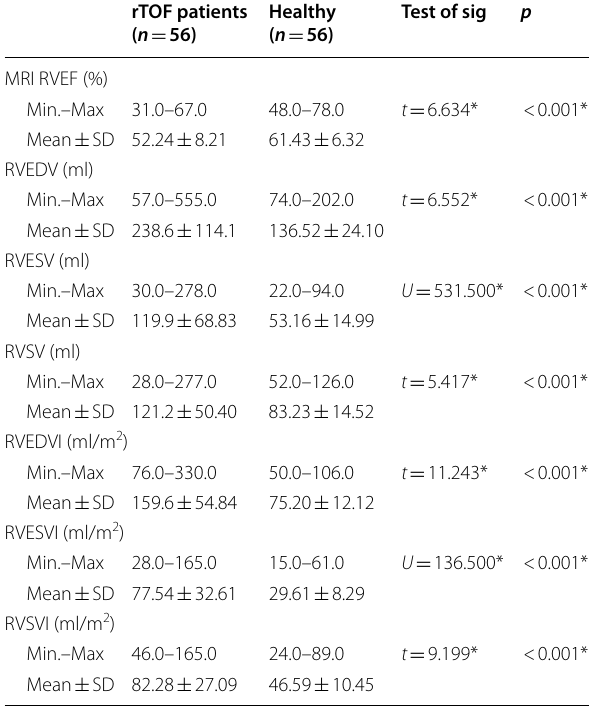
Table 8 Comparison between the two studied groups (56 rTOF patients and 56 healthy volunteers) regarding different CMR LV volumetric and function